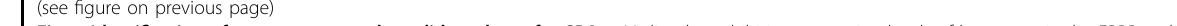
Fig. 7 Identi fi cation of target genes and candidate drugs for SBA. a Violin plot exhibiting expression levels of key genes in the ERBB pathway and the ERBB family gene set score in the malignant cells and normal epithelial cells in the integrated dataset of the STRT and 10× datasets, with “ ns ” representing no signi fi cance and P values calculated by t -test. b Representative IHC staining of ERBB2 in adjacent normal and primary tumor tissues (original magni fi cation 100×). The rows of the paired normal and tumor samples are from the same patients, and three individual patients are listed. Scale bar, 100 μ m. c Violin plot showing MUC1 expression in normal epithelial types from the 10× dataset. d Scatterplot exhibiting the positive correlation of expression of MUC1 and other genes. e The brief work fl ow of drug predication. f Scatterplot exhibiting the log 2 FC of tumor sample compared with normal samples and correlation with tumor score according to the predicted IC 50 AUC value of every drug. Drugs with labels were selected as candidate drugs. g Cell survival curve for HUTU-80 cells treated with the indicated inhibitors with a dose escalation from 0 to 100 μ M. Data are presented as means ± SD. h UMAP plot identi fi ed the differences of malignant cells and normal epithelial cells based on transcriptional changes induced by drugs from databases built in Beyondcell. i Drug sensitivity of tozasertib and irinotecan evaluated in single cells from the STRT dataset based on